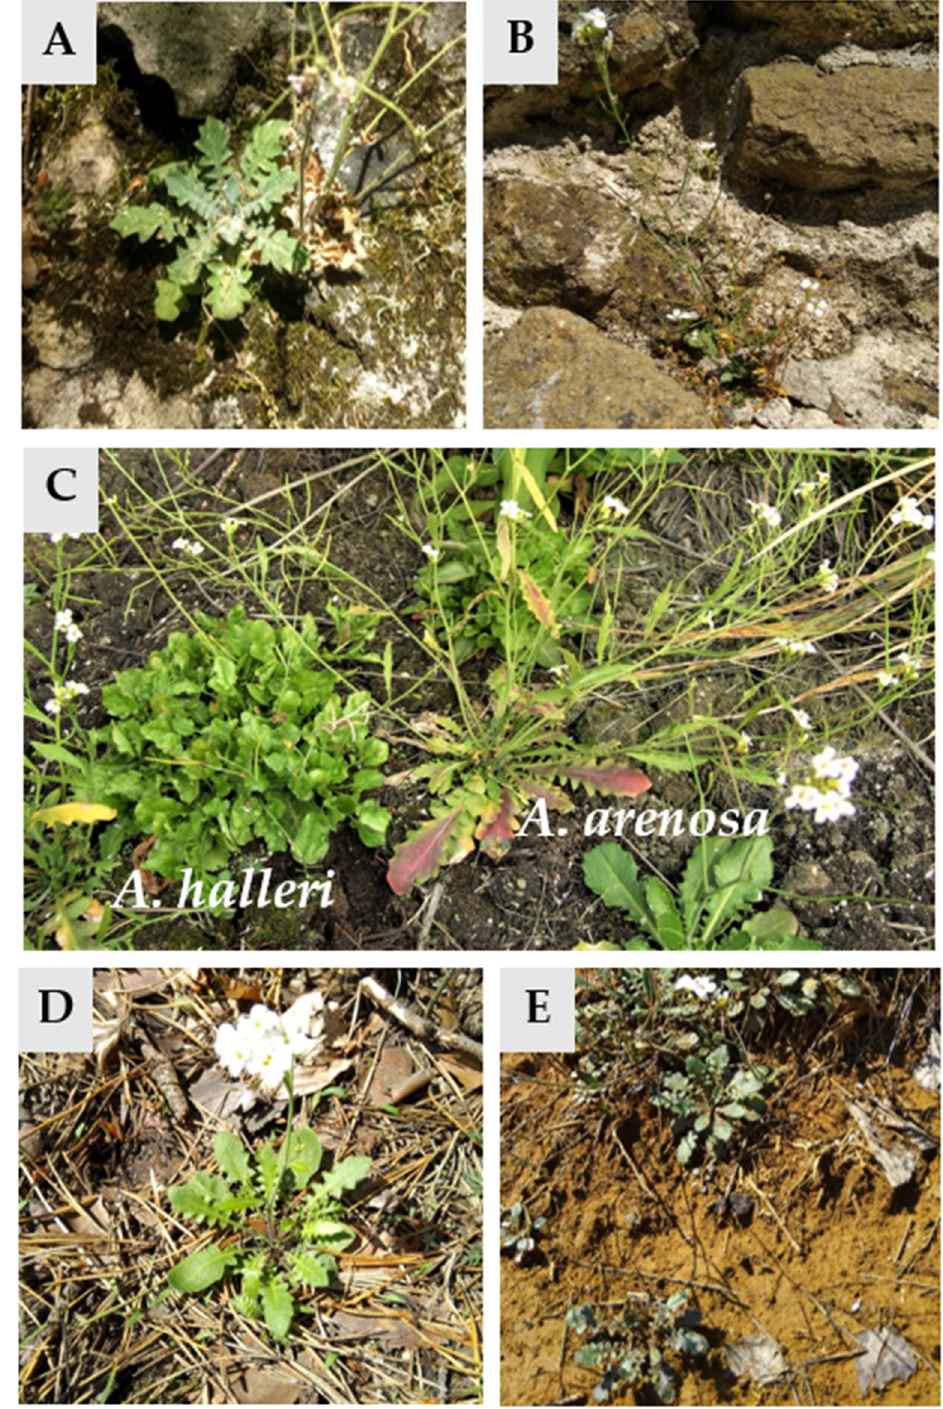
Figure 1. Pictures of Arabidopsis arenosa in situ. ( A )—diploid (2C) from Csesznek, Hungary; ( B )—diploid (2C) from Szigliget, Hungary; ( C )—comparison of A. arenosa (4C) and A. halleri (2C) in Piekary Ś l., Poland; ( D )—tetraploid (4C) from Klucze, Poland; ( E )—tetraploid (4C) from Dołki, Poland. A. arenosa is a biennial or short-lived perennial herb. The leaves are arranged in a rosette at the ground level, and no runners form from the rosette. The shape of the leaf blade is obovate to oblanceolate, pinnatifid to lyrate-pinnatifid and with three to eleven lateral lobes on each side. The stems of this plant species are erect, simple, or with few or more branches from the base. A. arenosa produces tiny flowers whose petals are white to lavender, obovate, obtuse or cut at the apex [2]. The siliques of A. arenosa are always